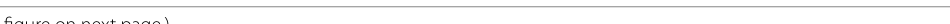
(See figure on next page.) Fig. 8 c-Fos activation map of brain stem structures in the LEV-induced chronic migraine model. A. Representative pictures of c-Fos (red) and NeuN (green) immunofluorescence labeling in the vlPAG. Scale bars 100 μm. B‑C. In vlPAG, no significant differences in c-Fos + cell density = ( B ) and the percentage of c-Fos cells in NeuN + cells ( C ) were found. n 5/group. D. Representative pictures of c-Fos (red) and NeuN (green) + = immunofluorescence labeling in the Sp5c. Scale bars 50 μm. E–F. Sp5c showed a significant increase of c-Fos + cell density ( E ) and the percentage = of c-Fos + cells in NeuN + cells ( F ), alleviated by OLC. n 5/group. One-way ANOVA with the Tukey post hoc tests, * P < 0.05, ** P < 0.01. Abbreviations: = vlPAG, ventrolateral periaqueductal gray; OLC, olcegepant; Sp5c, caudal part of the spinal trigeminal nucleus; LEV,